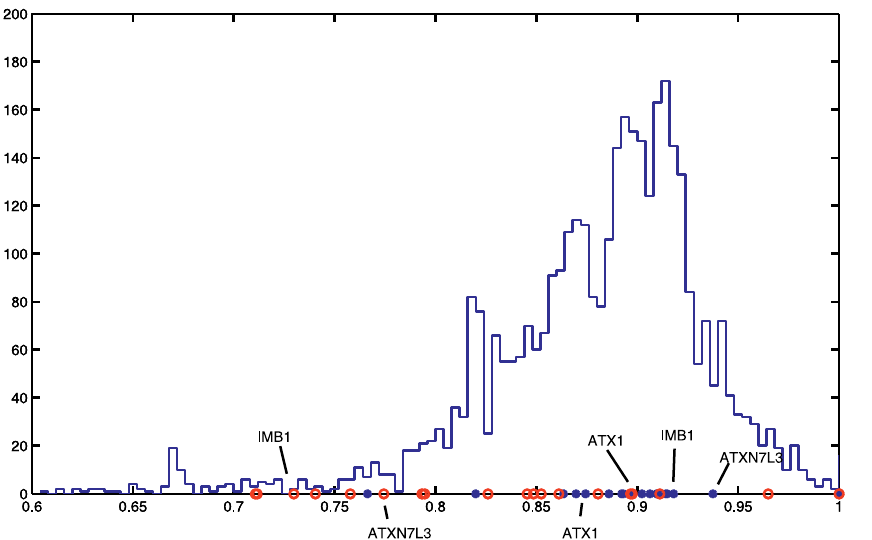
Figure 8. Conservation between Human and Mouse Gene and Pseudogene Sequences for the 20 Syntenic S 1 Sequences Blue stars indicate genes. Red circles indicate pseudogenes. The histogram shows, for reference, the conservation of all genes giving rise to pseudogenes. Compare with Table 5, which lists the same data. DOI: 10.1371/journal.pcbi.0020046.g008